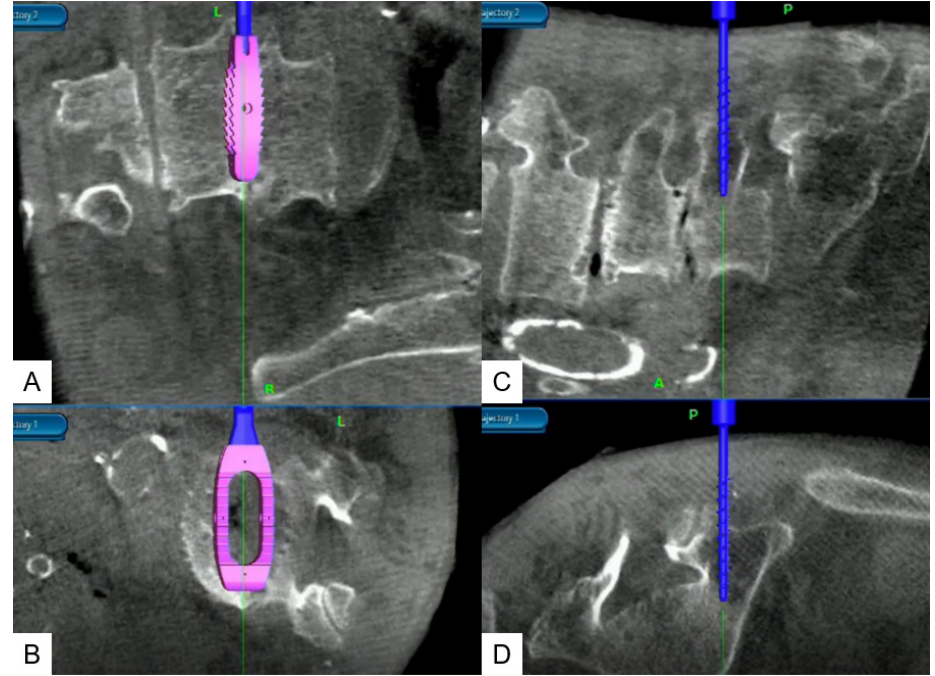
Figure 2. O-arm images showing navigated cage and screw placement. ( A ) Coronal view of the cage insertion; ( B ) Axial view of cage insertion; ( C ) Sagittal view of PS insertion; ( D ) Coronal view of PS insertion.